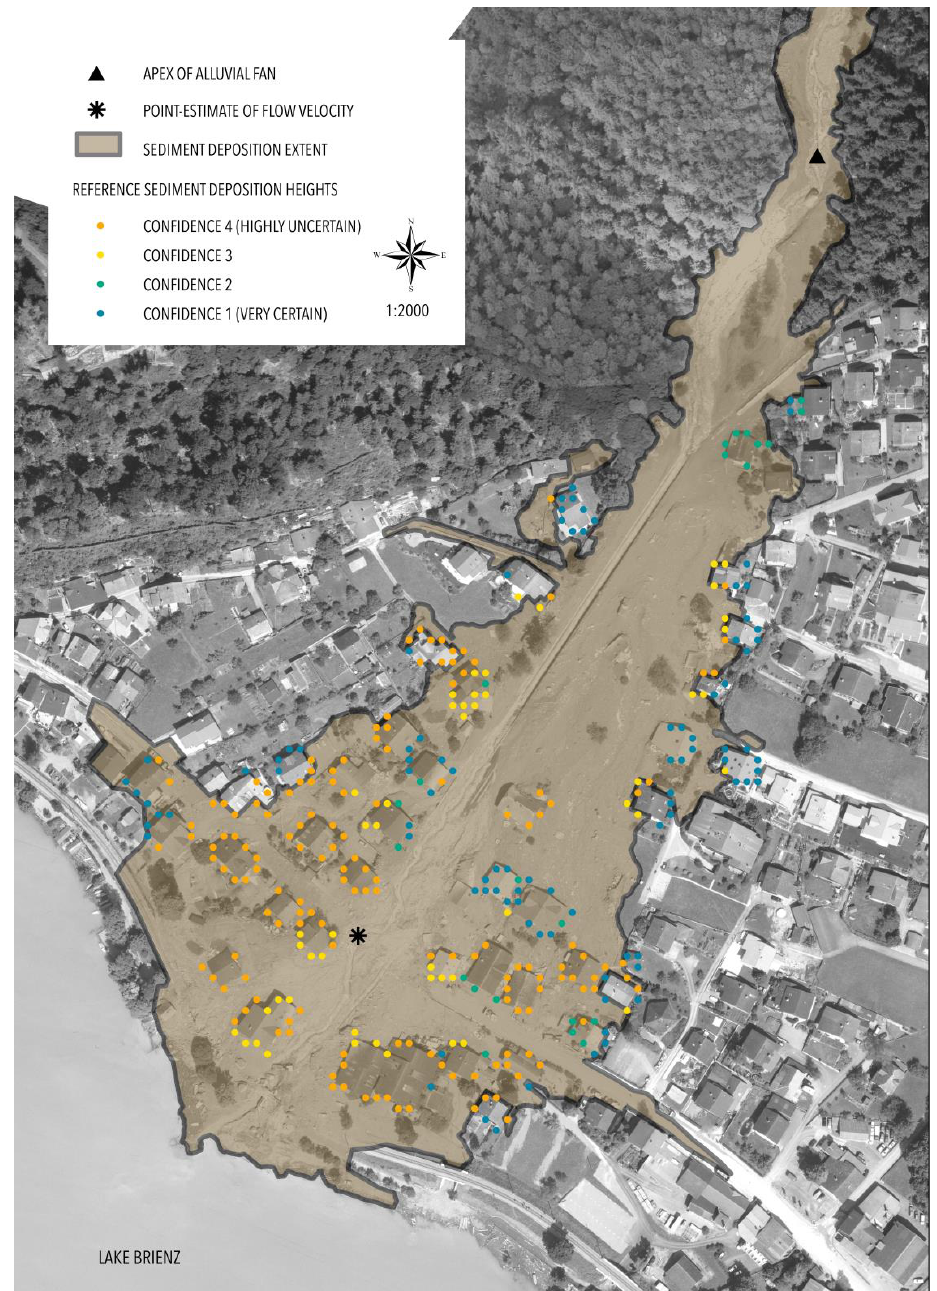
Figure 3. Two main sets of reference data are available for the study site including sediment deposition extent and 317 point estimates of sediment deposition heights that are associated with spatial coordinates and confidence levels.